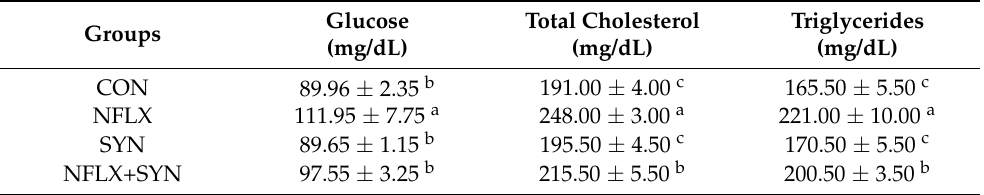
Table 4. Changes in serum glucose, total cholesterol, and triglycerides in O. niloticus fed diets supplemented with antibiotic (norfloxacin, NFLX) and synbiotic